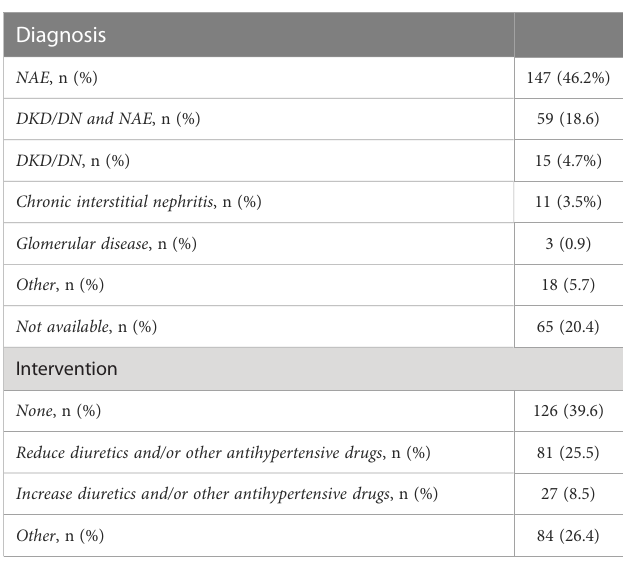
TABLE 2 Suspected diagnosis and interventions after fi rst Nephrology